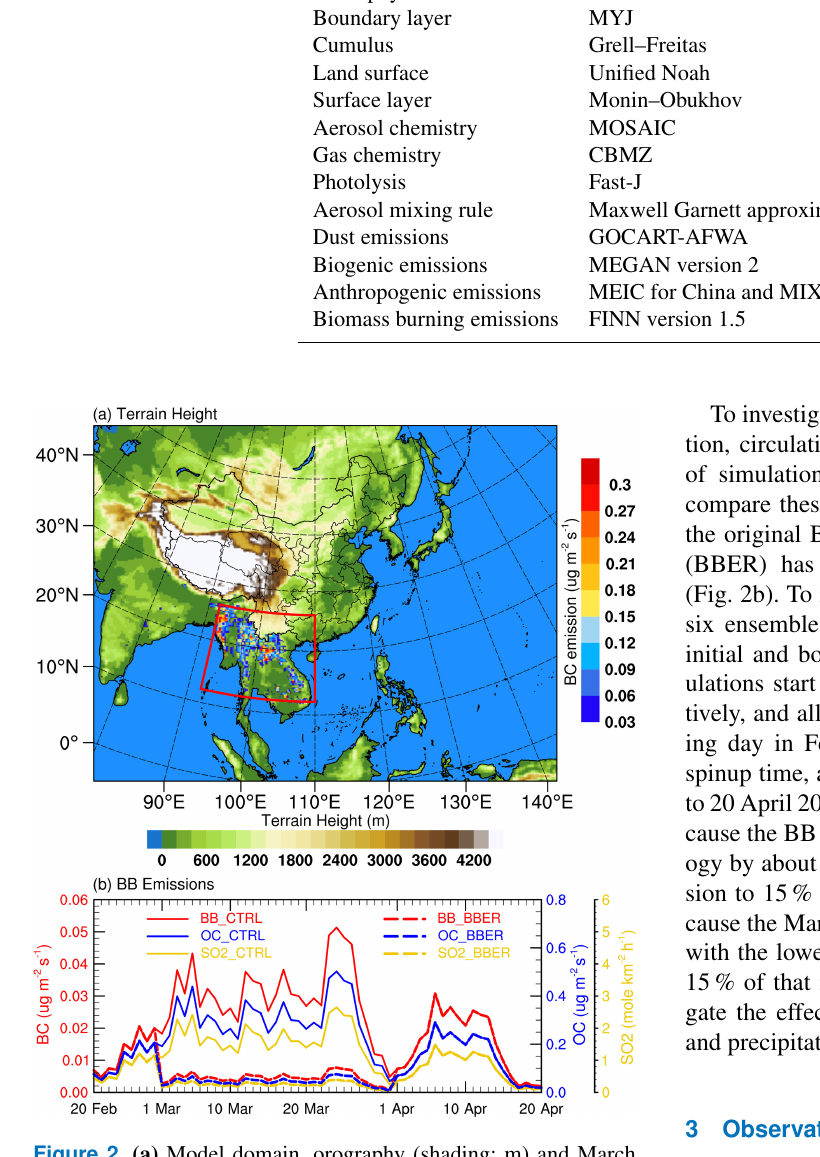
Figure 2. (a) Model domain, orography (shading; m) and March BC emission input in the model from BB based on the Fire IN- ventory from NCAR (FINN) version 1.5. (b) The time series of BB emissions (BC, OC, and SO 2 ) averaged over Indochina (92–110 ◦ E, 12–26 ◦ N, as outlined by the red box in panel a ) from 20 February to 20 April 2010. The solid curves are the emissions for the con- trol experiment (CTRL). The dashed curves are the emissions for the sensitivity experiment (BBER); i.e., the March emissions are reduced to